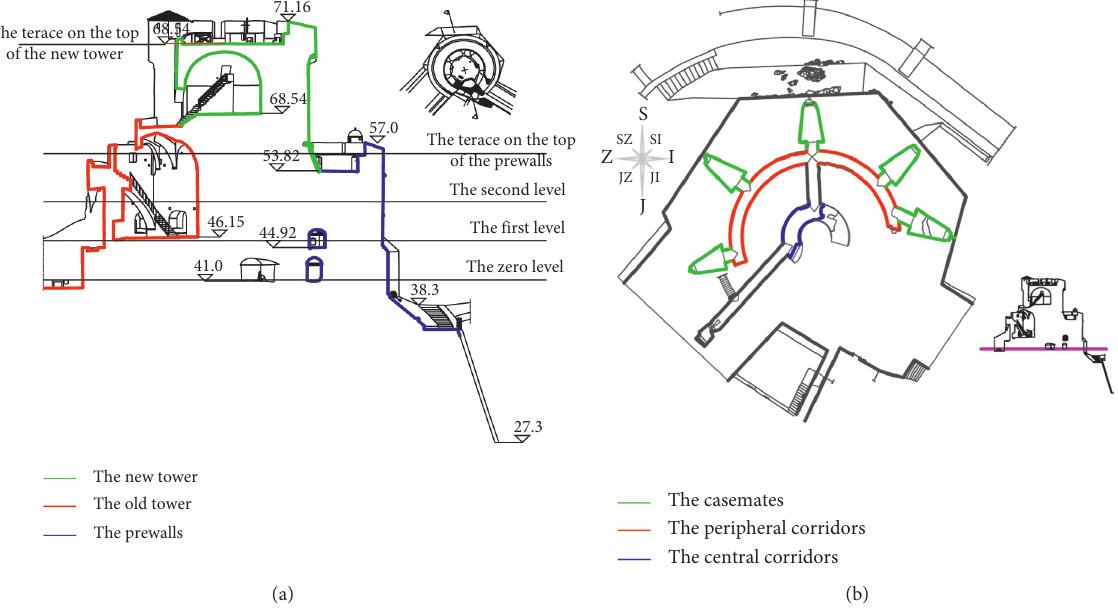
Figure 8: Vertical cross section (a) and floor plan at the zero level (b) of the Minceta